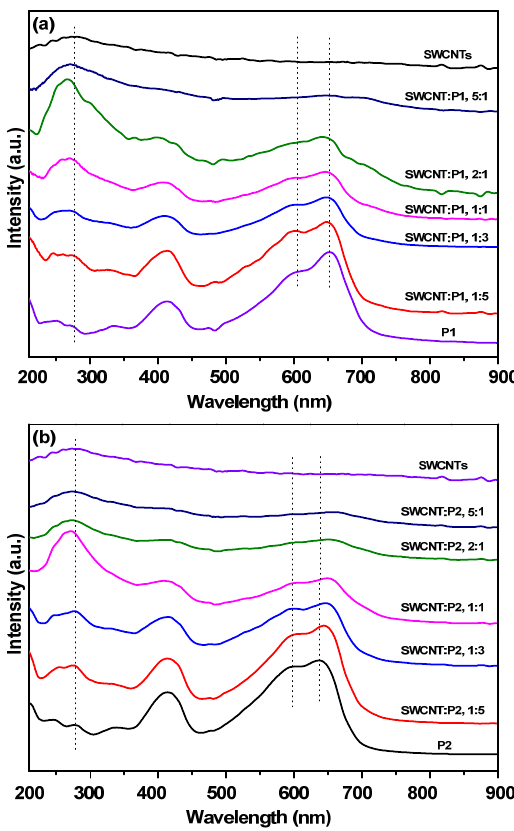
Figure 2. UV-Vis absorption spectra of ( a ) P1 / SWCNTs and ( b ) P2 / SWCNTs composite films with varying the amounts of SWCNTs.